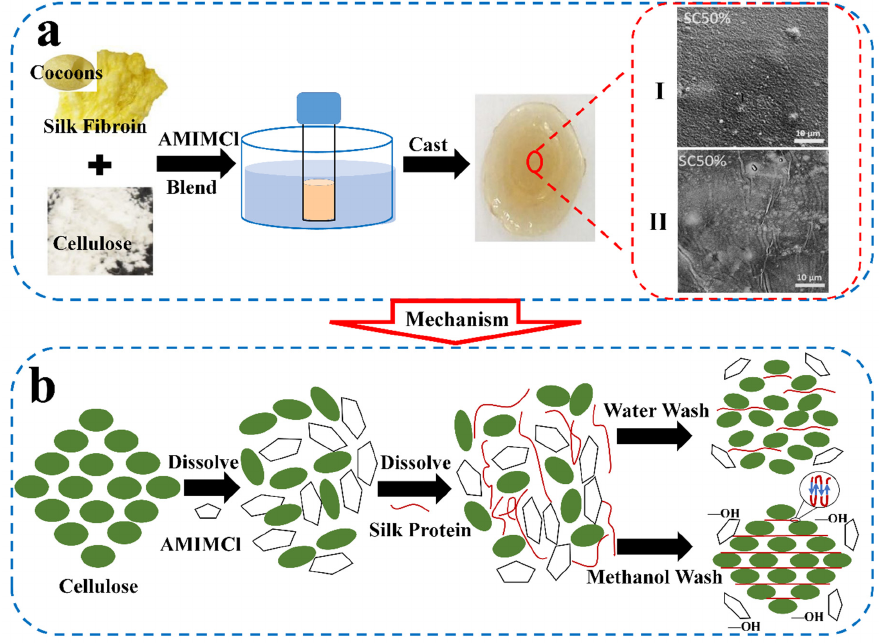
Figure 7. ( a ) Schematic diagram of preparing process of SF/cellulose film using IL [AMIM]Cl as solvent. The SEM images of blends with different mass ratios under methanol treatment (I) and water treatment (II) are shown. ( b ) The blending mechanism in IL [AMIM]Cl system (reproduced with permission from [103], Copyright (2017) Elsevier).